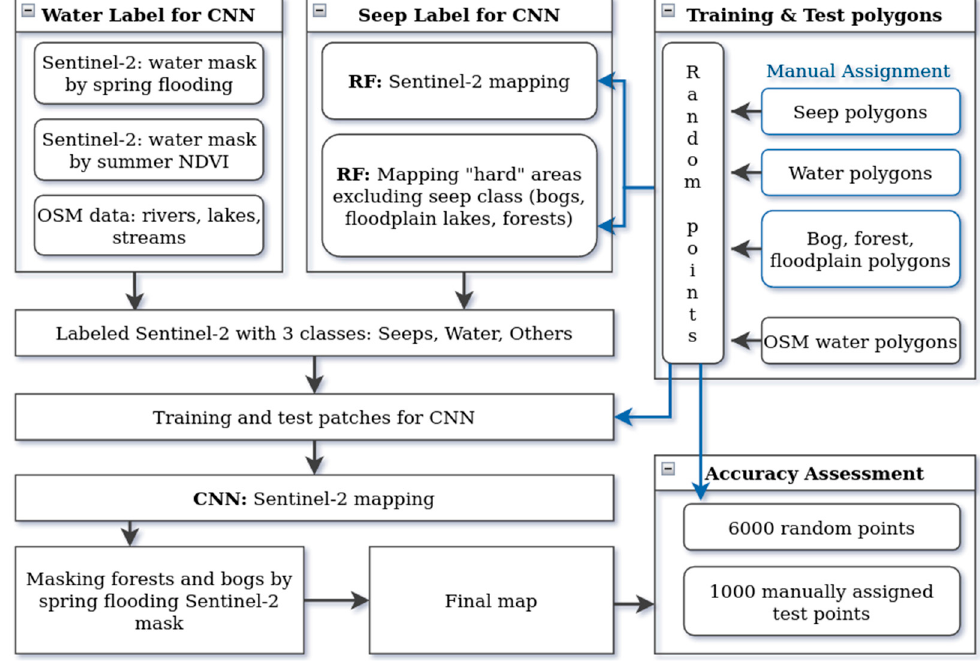
Figure 3. Flowchart describing the workflow for deriving high-resolution seep map using Senti- nel-2 data and CNN. data and